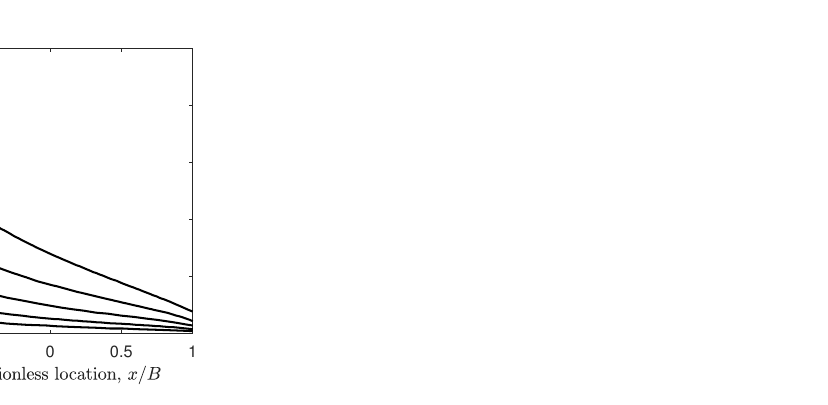
Figure 6. Distribution of dynamic pressure along the bottom of the obstacle under different val- ues of wave frequency: ω ( s − 1 ) = 0.5,0.6,0.7,0.8,0.9 (top to bottom). In all cases, ρ w / ρ m = 0.9, ν m = 0.001 m 2 /s, d = δ m , B = 30 m, W = 30 m, and W / h = 0.1.